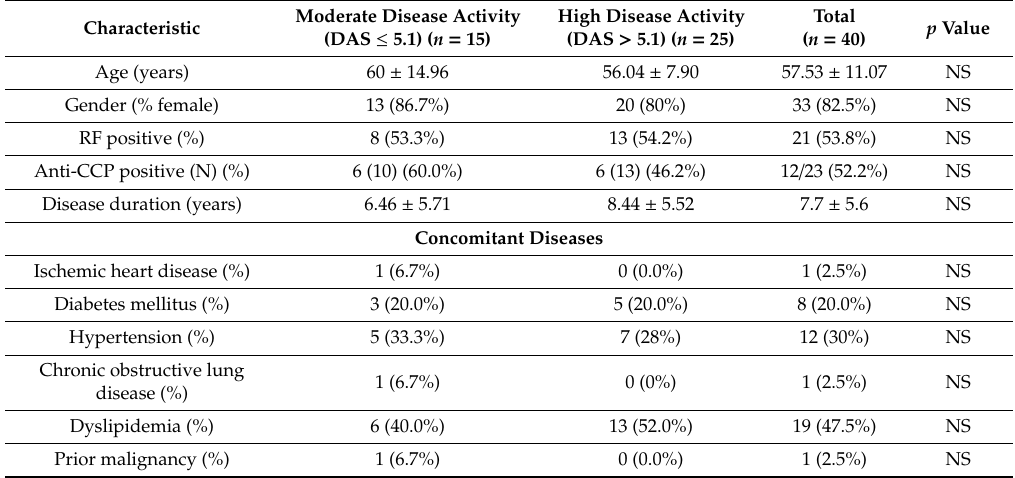
Table 1. Patients demographic and clinical characteristics according to disease activity at